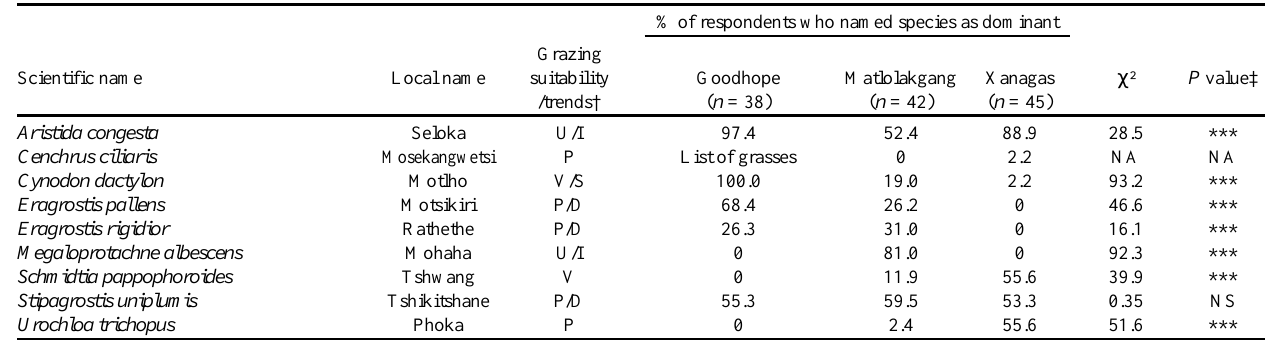
Table 2 . Proportions of pastoral farmers who indicated that different grasses were dominant within their rangelands. % of respondents who named species as